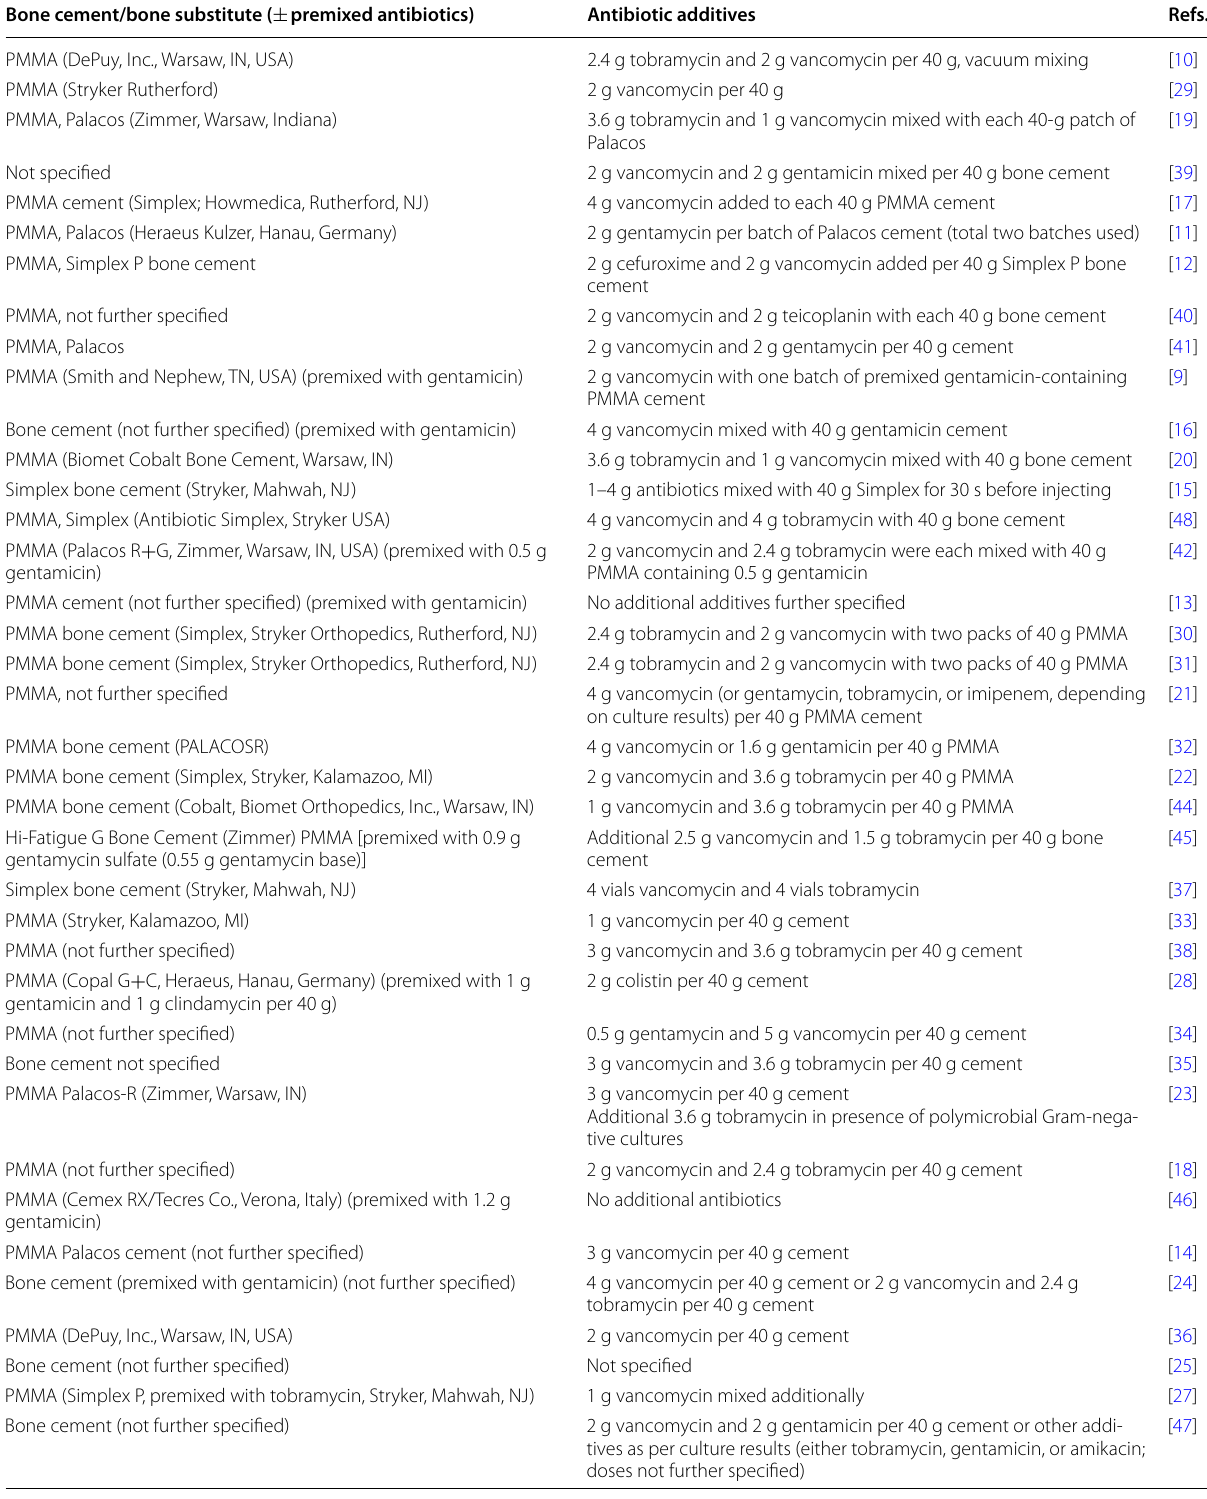
Table 4 Summary of type of cement or bone graft substitute and type and quantity of antibiotic additives used for the coating mantle Bone cement/bone substitute ( premixed antibiotics) Antibiotic additives ±